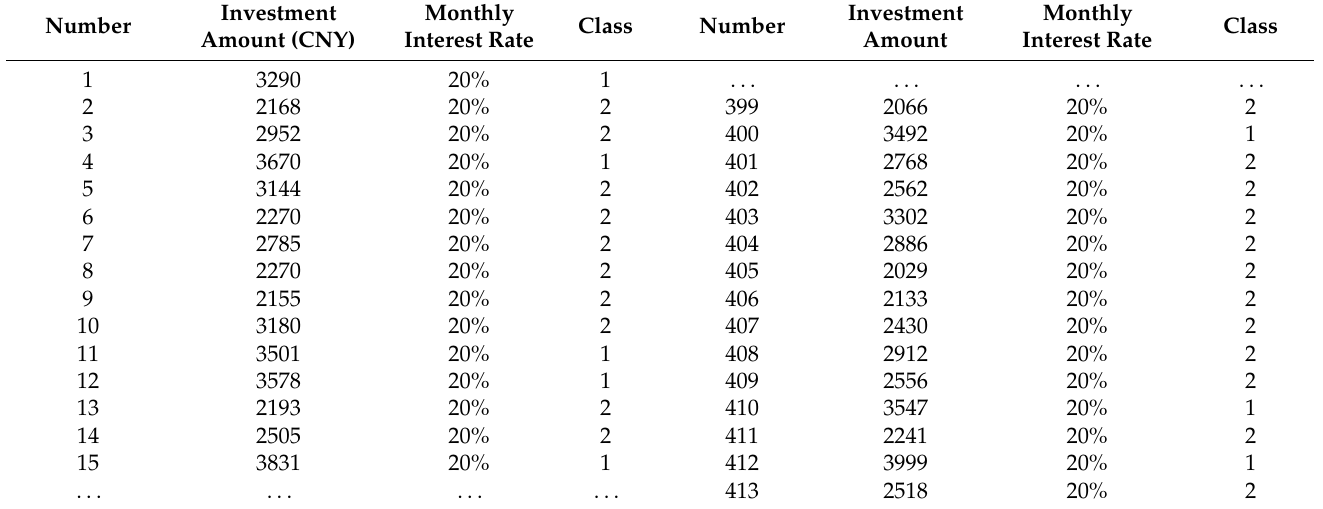
Table A5. Test set data.